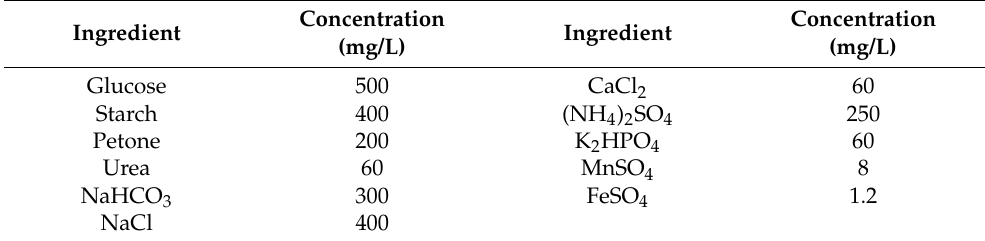
Table A2. Composition and concentration of synthetic wastewater.